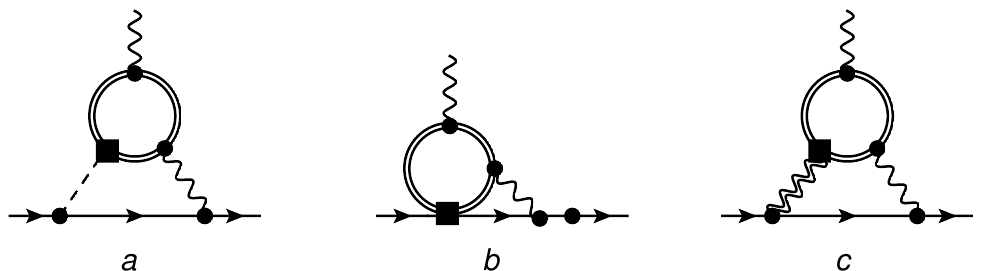
Figure 1 . Two-loop diagrams contributing to the electron EDM. Single (double) lines denote the electrons (top quarks), dashed lines the Higgs boson, and wavy single (doubles) lines the photons (Z-bosons). Circles denote SM vertices, while squared denotes CPV dimension-six vertices. Only one topology for each diagram is